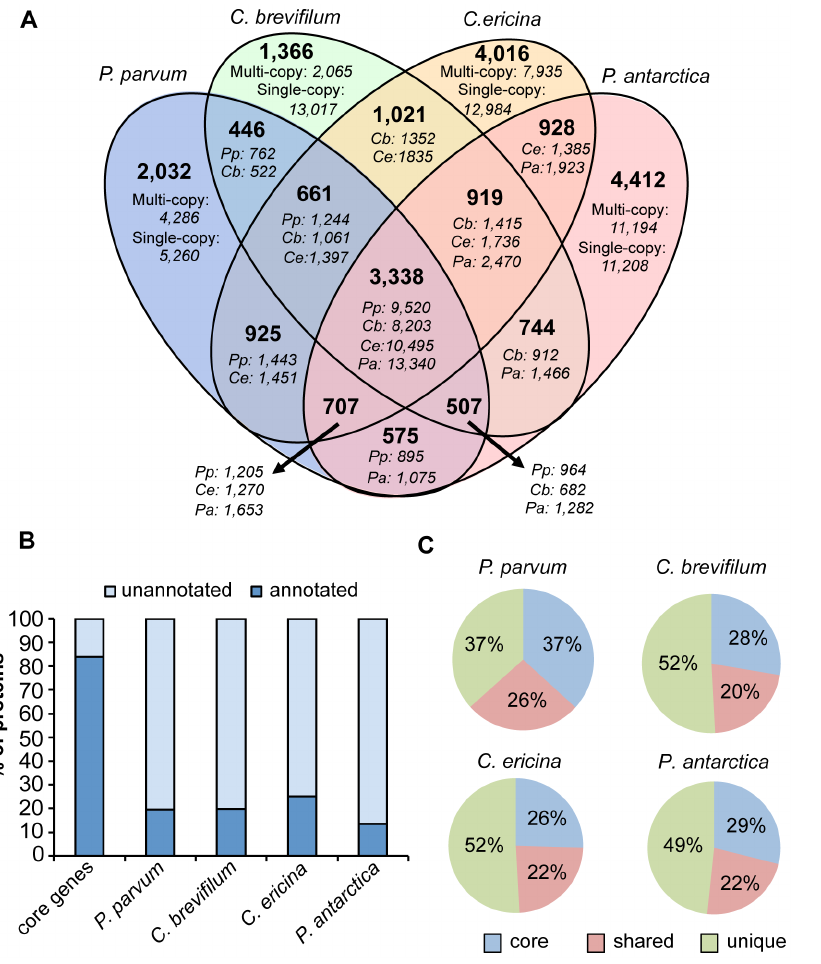
Figure 1. Core, shared and unique transcriptome genes in four prymnesiophyte species: Prymnesiumparvum , Chrysochromulina brevifilum , ChrysochromulinaericinaandPhaeocystisantarctica . A) Venn diagram showing the number of shared or unique genes (in italics) and gene clusters (in bold) among the four prymnesiophytes as classified by the orthomcl program. Among the genes unique to each of the four prymnesiophytes, multi-copy genes refer to genes that were present in gene clusters, single-copy genes refer to genes that did not cluster with any other gene. Pp: Prymnesium parvum , Cb: Chrysochromulina brevifilum , Ce: Chrysochromulina ericina , Pa: Phaeocystis antarctica . B) Proportion of annotated and unannotated genes in the ‘‘core’’ gene set, i.e. genes shared by all four species, and in the gene set unique to each species. C) Proportion of the transcripts that comprised core, shared and unique genes. Shared genes are genes present in two or three of the four species. Unique genes are genes that are only present in one species.